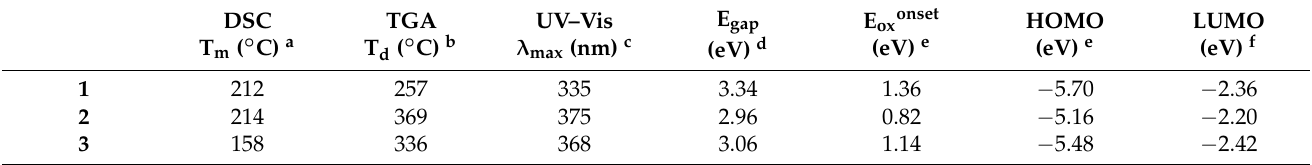
Table 1. Thermal, optical, and electrochemical properties of BTBT derivatives.